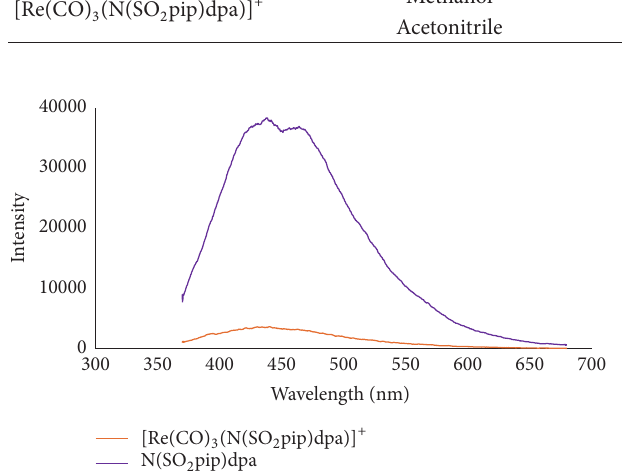
Figure 4: Fluorescence spectra of N(SO 2 pip)dpa and [Re(CO) 3 (N(SO 2 pip)dpa)] + in acetonitrile.